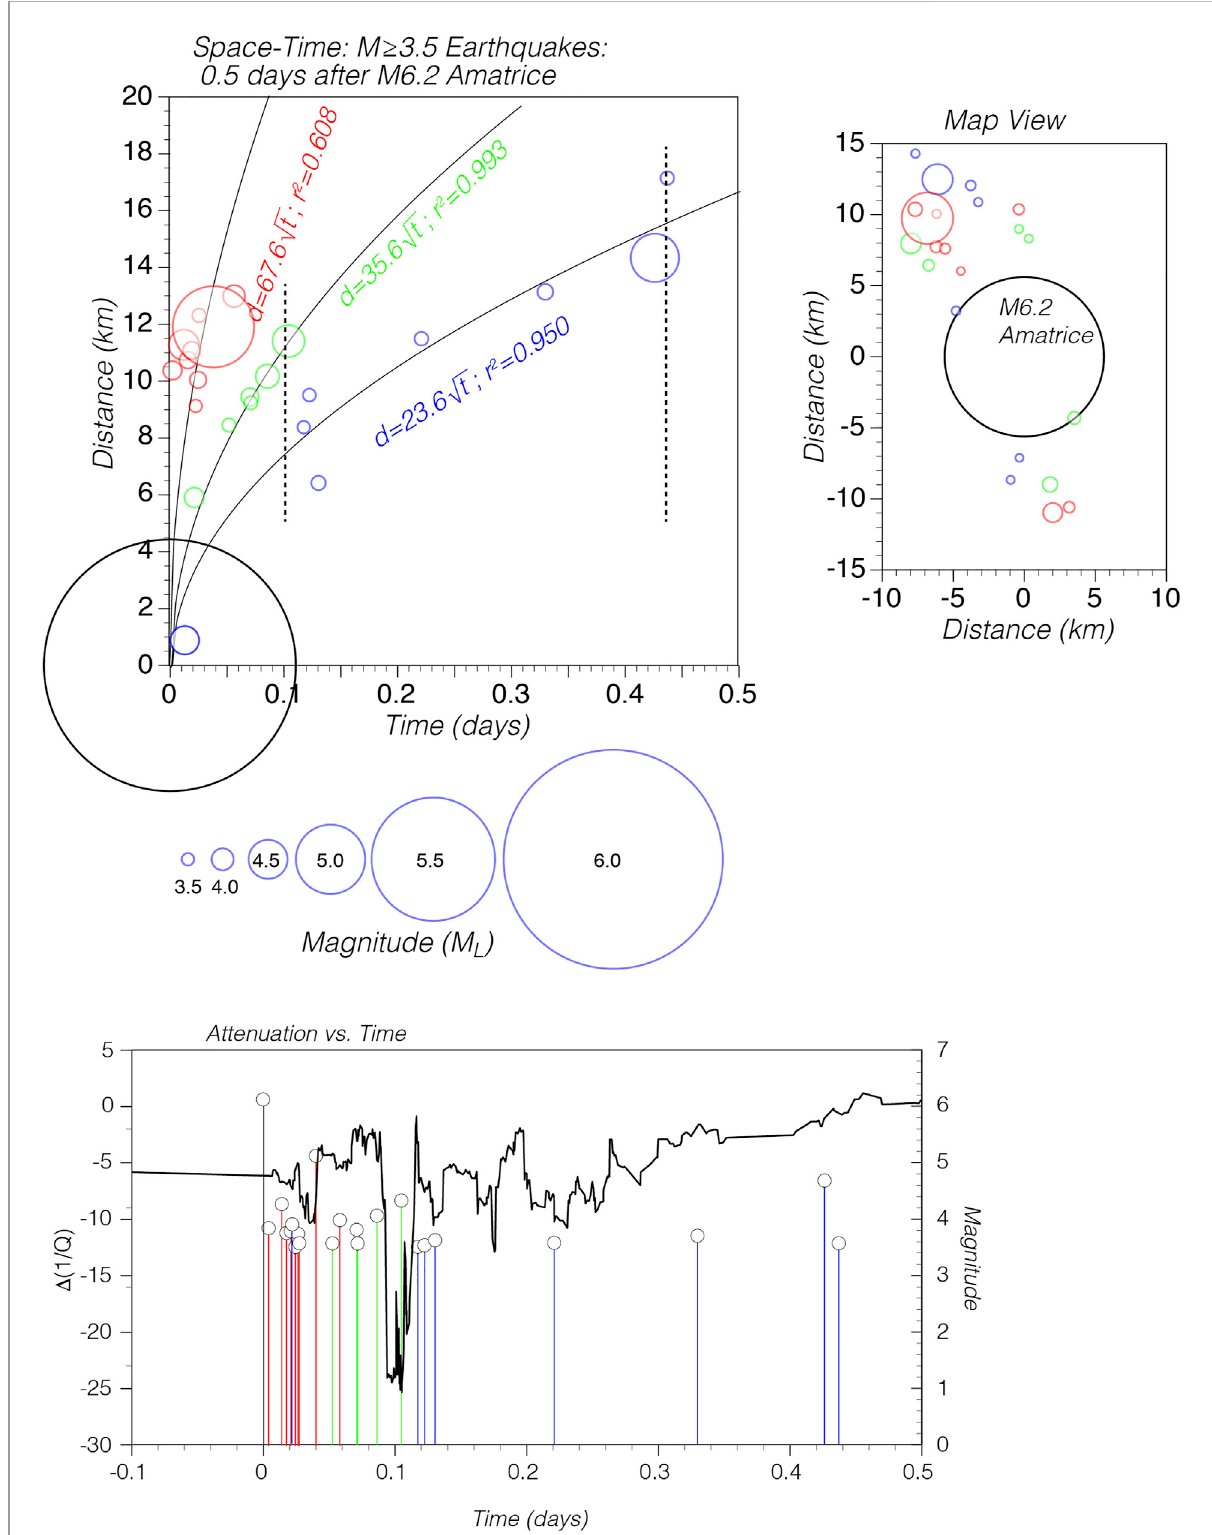
FIGURE 8 Diffusionandattenuationvs.time:Amatrice. Upper :threedifferentsimultaneousdiffusionprocessesmayberecognizedmostlytotheNorthof